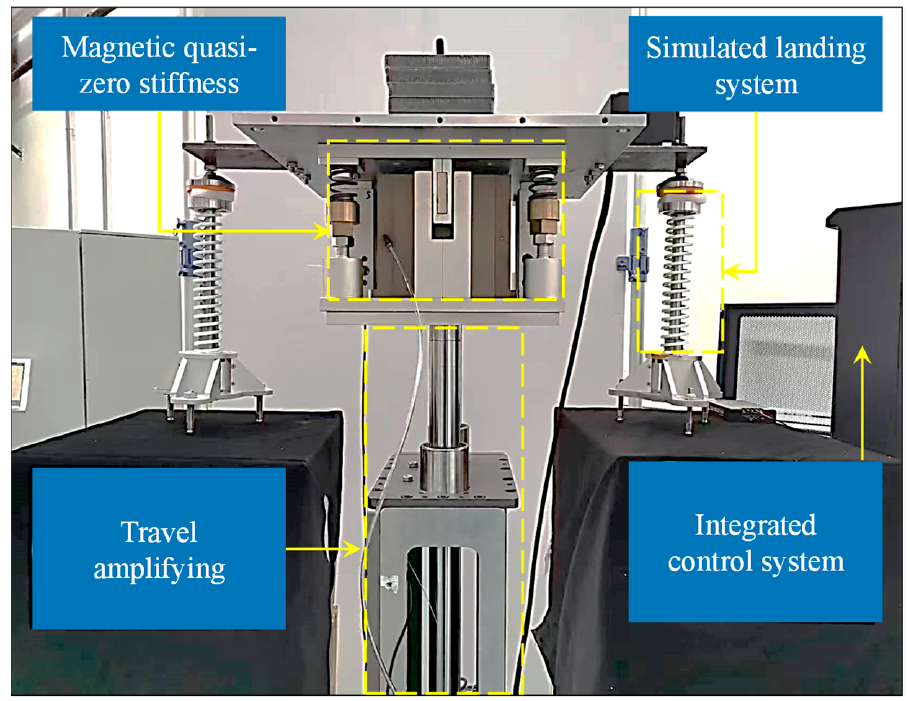
Figure 8. Prototype of landing buffer simulation test system for lunar vehicle.